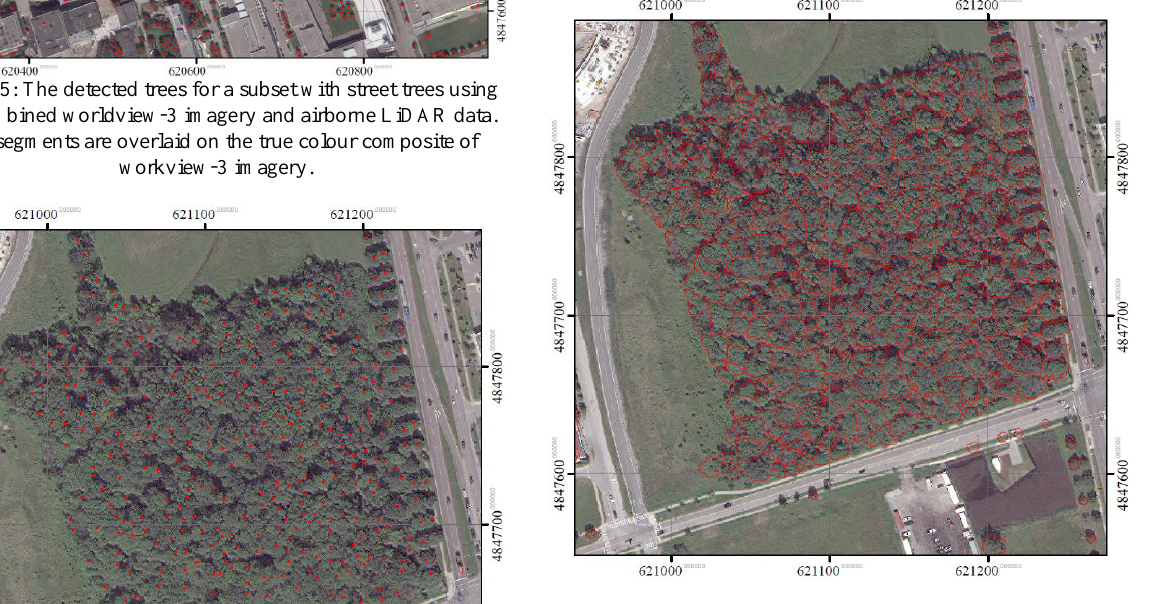
Figure 8: The tree segments for the woodlot subset.